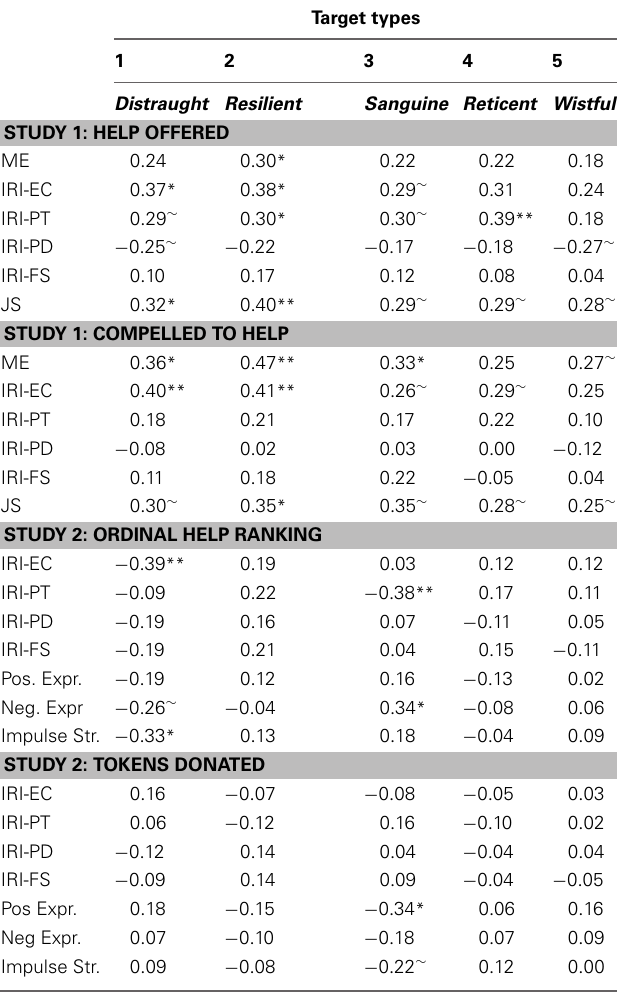
Table 3 | Prosocial responses correlated with trait empathy across studies and